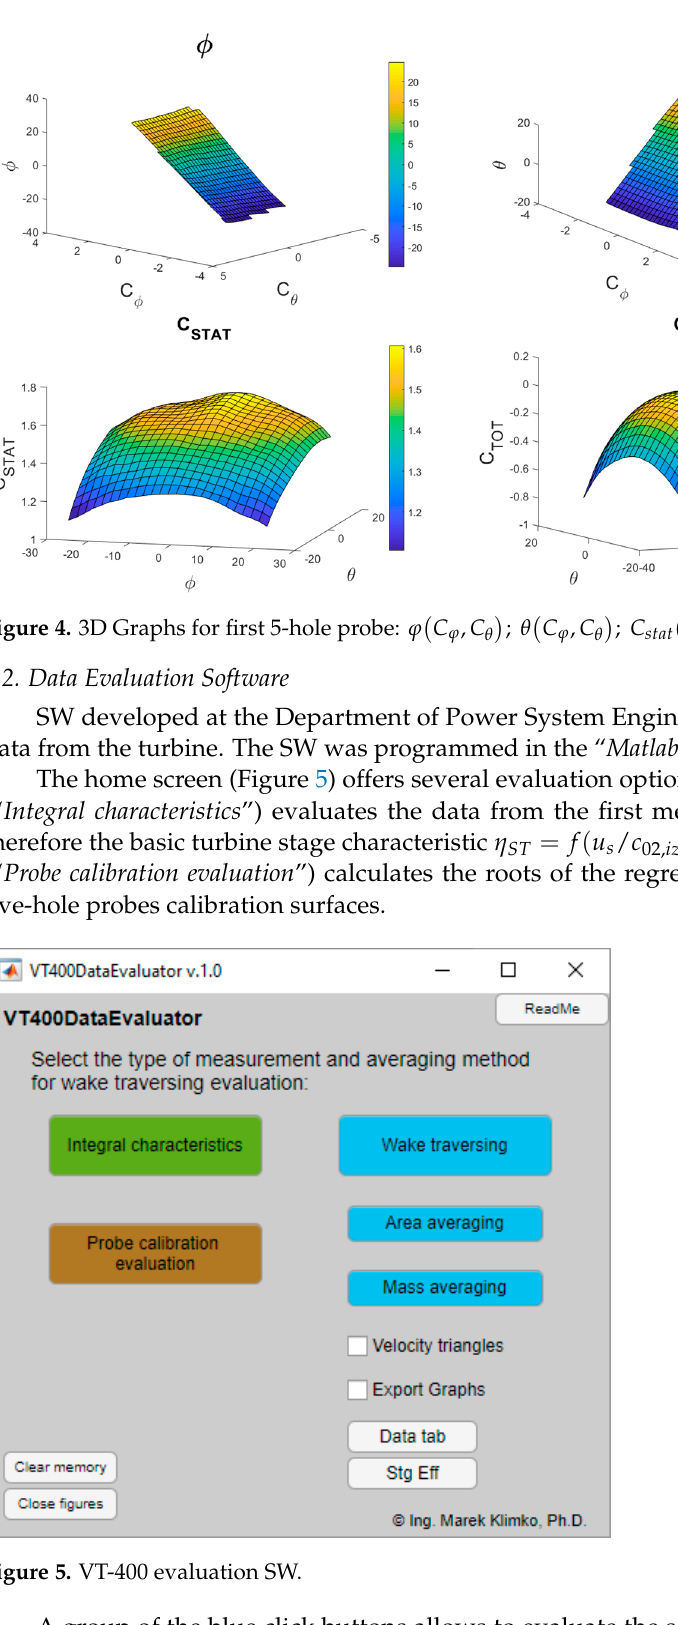
Figure 5. VT-400 evaluation SW.